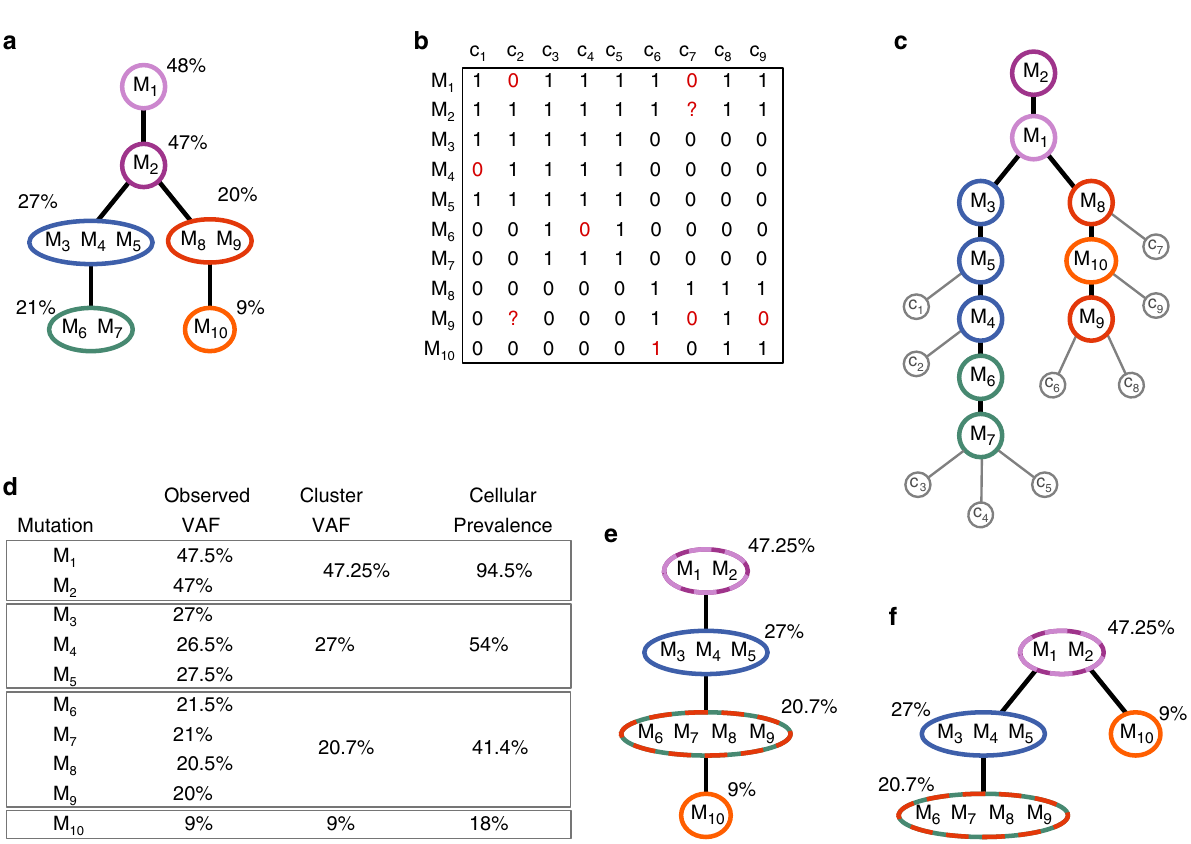
Fig. 1 Comparison of inferred mutation histories based on single-cell and bulk-sequencing data. a Ground truth clonal tree with mutations M 1 , … , M 10 : the coloured nodes represent the subclones, and the tree structure indicates the partial temporal order in which the subclones emerged (from top to bottom). Each subclone contains the mutations it acquired in comparison with its parent and is annotated with the mean VAF of these mutations. (For a heterozygous mutation in a copy-number-neutral region, the VAF is half the mutation ’ s cellular prevalence.) b Cell mutation pro fi les obtained from the SCS data for nine cells c 1 , … , c 9 : ‘ 1 ’ indicates the observed presence of a mutation, and ‘ 0 ’ absence. A ‘ ? ’ indicates a missing data point (NA), e.g., due to insuf fi cient coverage. The red ‘ 0 ’ s are false negatives (e.g., drop-out events), the red ‘ 1 ’ indicates a false positive. Due to these errors, the mutation matrix de fi nes no perfect phylogeny. c Inferred single-cell mutation tree annotated with single-cell placements. Not all cells can be placed, such that their observed mutation pro fi le matches with the mutations acquired along the lineage from the root to their attachment point. The branching point of the ground truth tree is inferred correctly, due to the strong signal that the red/orange and blue/green mutations do not occur in the same cell. However, mutation order in linear segments is not reliably inferred from the SCS data; especially in the right branch, a mutation with low prevalence ( M 10 ) is placed above a more prevalent mutation ( M 9 ) due to errors in the mutation pro fi les of cells c 6 , c 7 and c 9 . d Variant allele frequencies obtained from bulk sequencing. VAF-based clustering of mutations leads to merging of subclones. e , f Both clonal trees are compatible with the VAFs and the clustering inferred in ( d ). Due to the clustering and incompatible VAFs, the correct branching between the blue and red subclone is not inferred, but in both trees, mutation ordering is consistent with their true